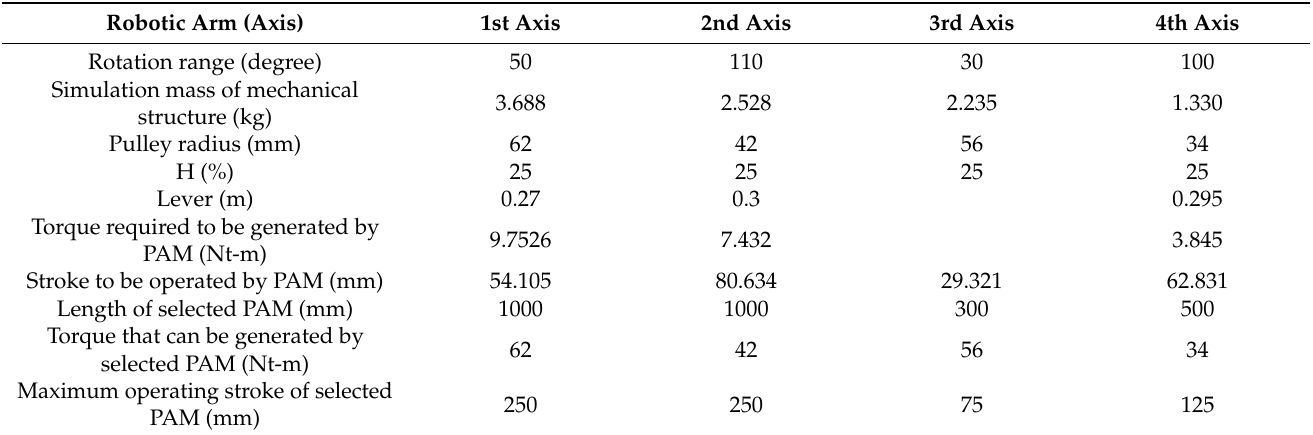
Table 3. Data used in selecting the